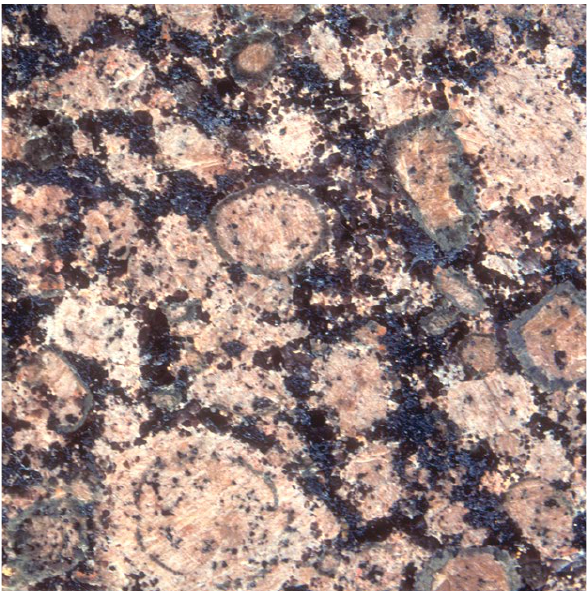
Figure 29. Rapakivi granites are completely inconsistent with melt cooling. They contain large rounded potash feldspars some of which are rimmed or have internal concentric zones of calcic-soda feldspar (plagioclase). Why are the rapakivi feldspars rounded, aggregated and some contain internal or external rims?